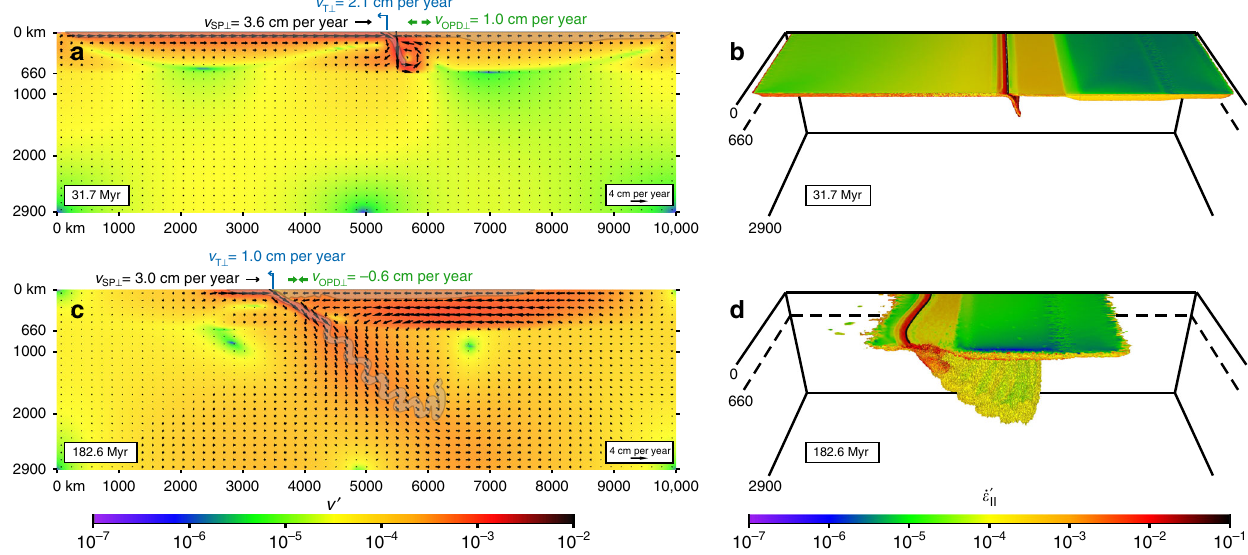
Fig. 2 Model results showing central cross-sections and 3D views of the subduction model simulating Nazca/Farallon oceanic plate subduction below the South American plate. a , b Upper mantle subduction stage (31.7 Myr, corresponding to the Middle Jurassic). c , d Whole-mantle subduction stage (182.6 Myr, corresponding to the Late Cenozoic). Cross-sections ( a , c ) show velocity fi eld and magnitude (vectors and colour scale; v ’ is the non-dimensional velocity), while transparent grey zones with dark grey outline show subducting plate-slab geometry and overriding plate geometry. 3D views ( b , d ) show non-dimensional second invariant of the strain rate in the plates and